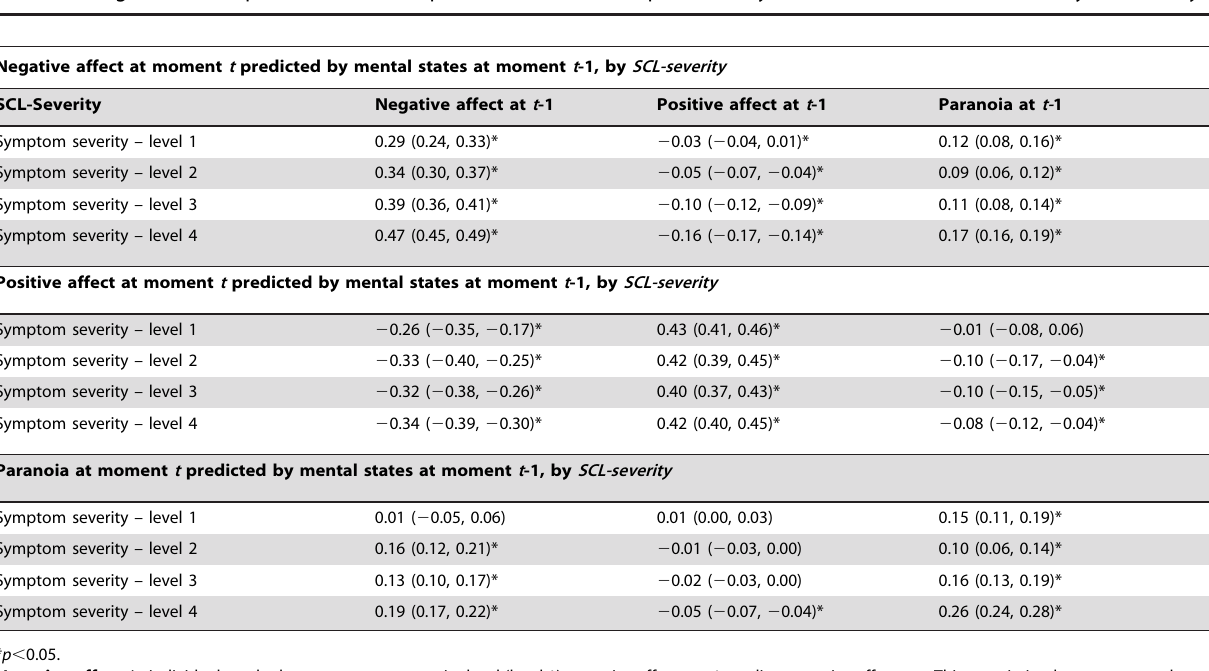
Table 2. Negative affect, positive affect and paranoia at moment t predicted by mental states at moment t -1, by SCL-severity.